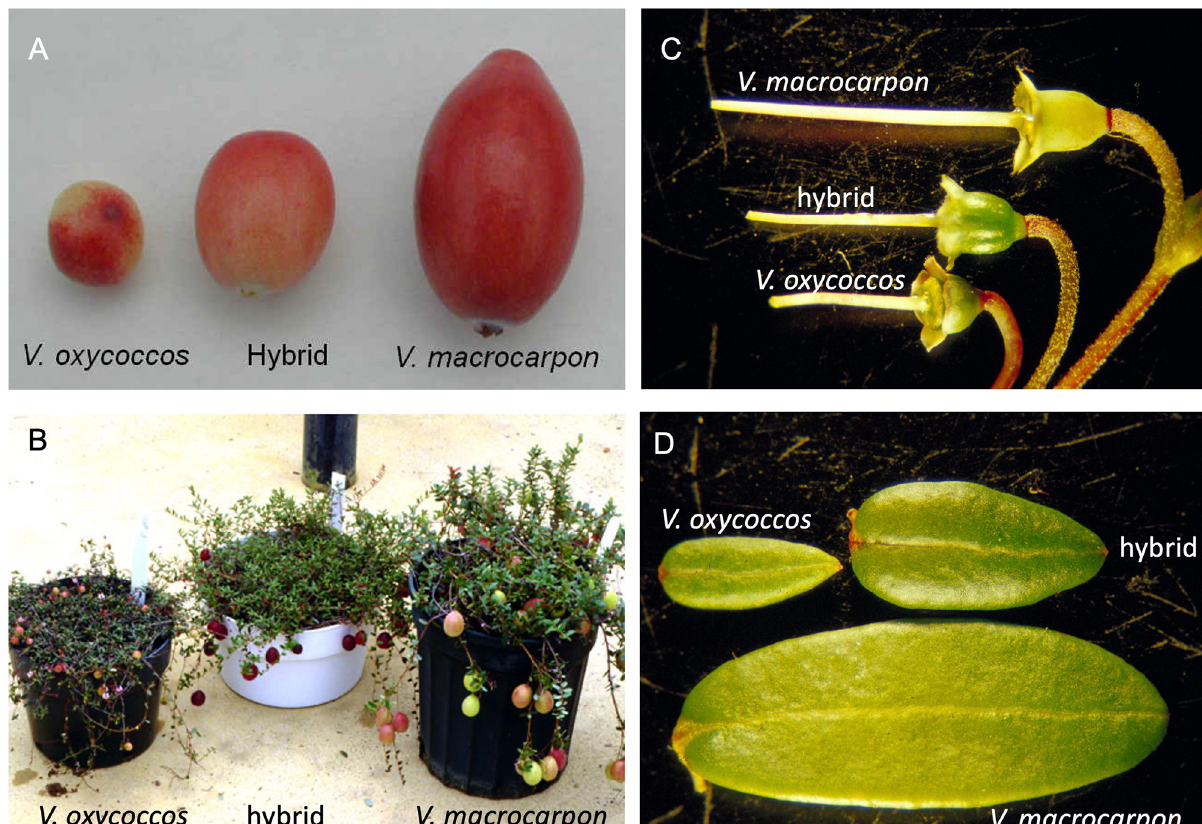
Fig 1. Vaccinium macrocarpon (Vmac) and Vaccinium oxycoccos (Voxy) are interfertile and have distinct morphology. A) Fruit, B) plants, C) pistils (attached to pedicels), and D) leaves from Vmac, Voxy and the interspecific F1